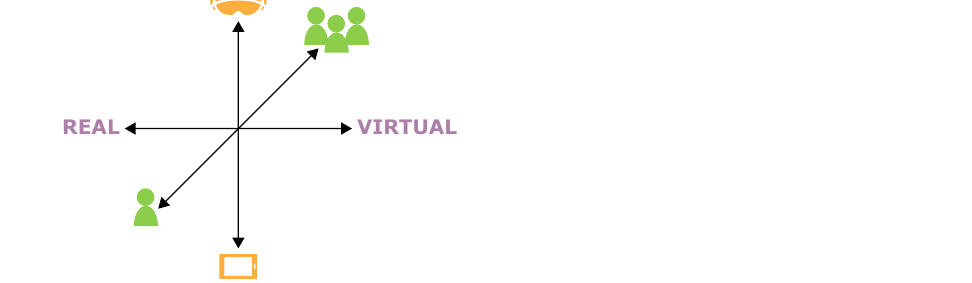
Figure 2. Scalable extended reality (XR S ) spaces providing scalability between different (cid:4) degrees of virtuality, (cid:4) devices, and (cid:4) numbers of